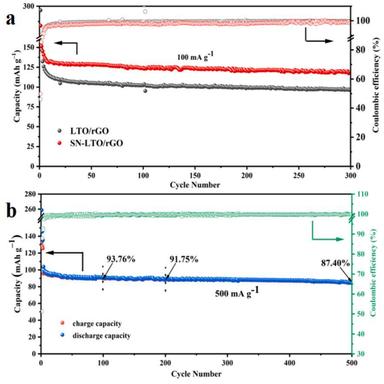
Cycling performance of LTO/rGO and SN-LTO/rGO electrodes at current densities of 100 mA g−1 (a) and 500 mA g−1 (b).